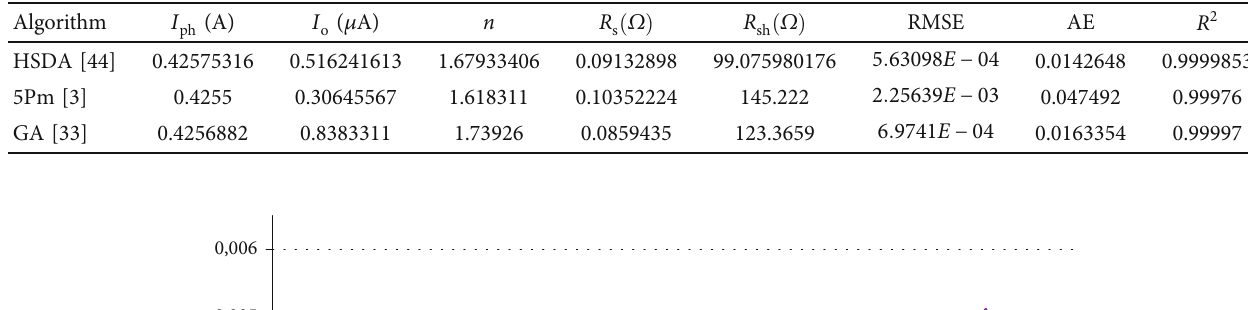
Table 4: The parameters and statistical tests for mSi commercial photovoltaic cell.